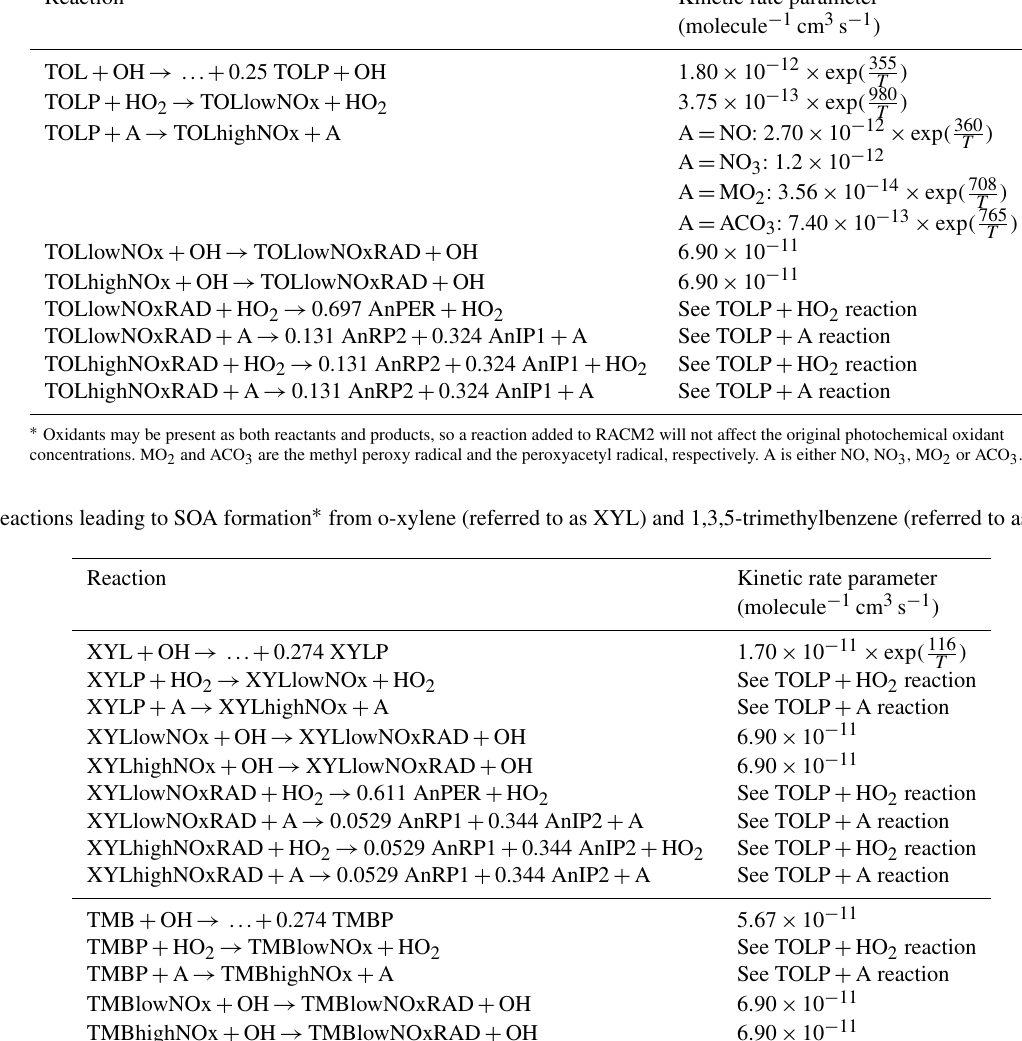
Table 4. Reactions leading to SOA formation ∗ from toluene (referred to as TOL). Reaction